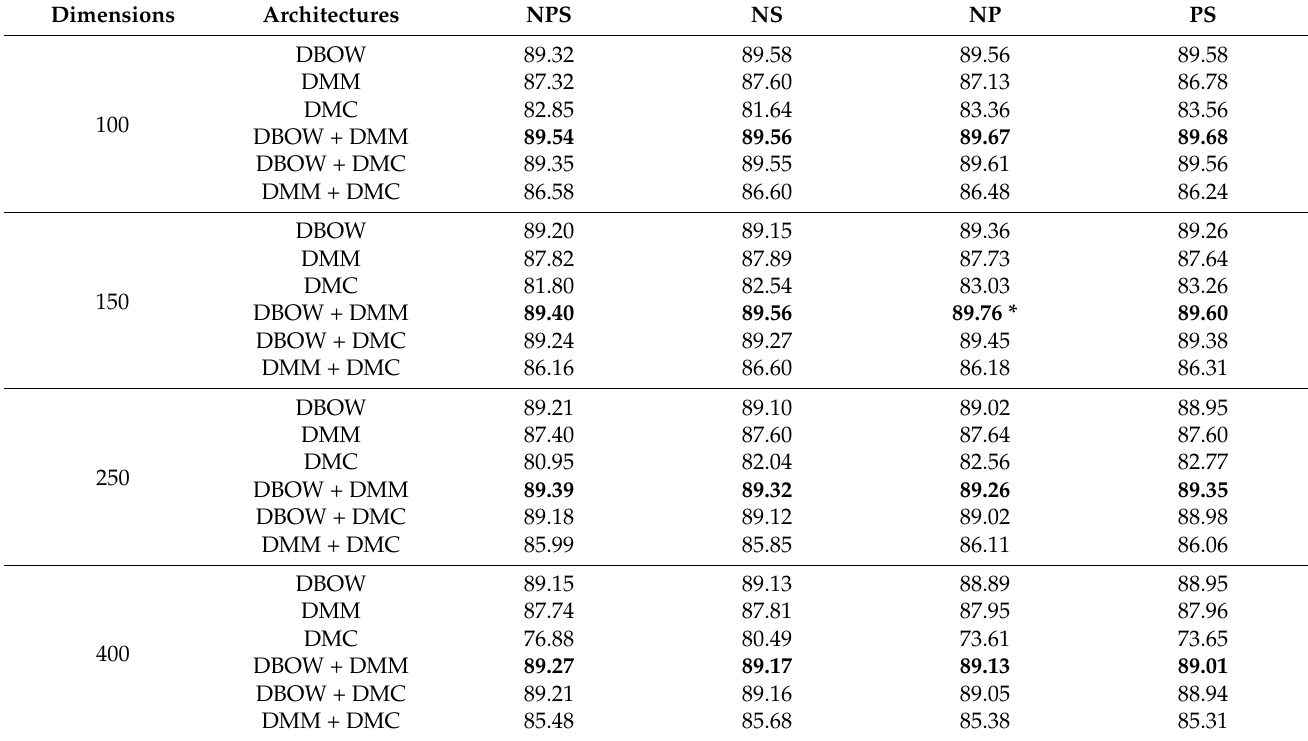
Table 2. Best evaluation results (or accuracy %) for dimensions and architectures.